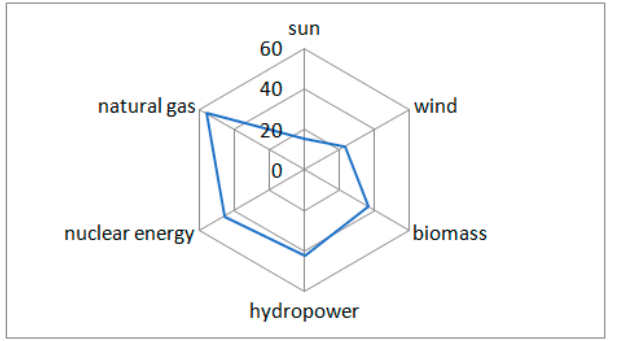
Figure 32. Standard deviation of RES [78].